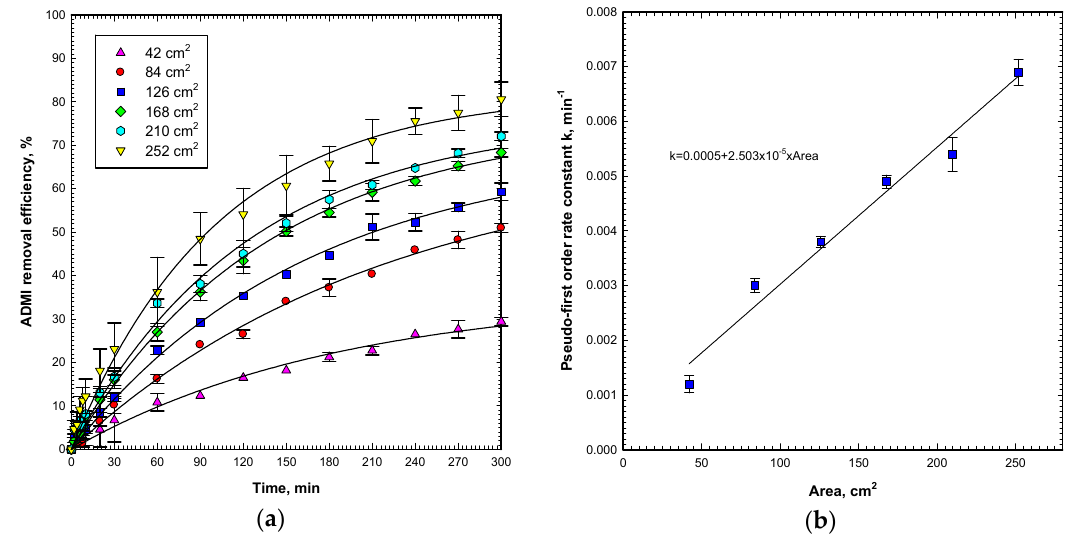
Figure 7. Effect of the loaded area of the catalyst on ( a ) OG degradation and ( b ) the first-order rate constant by the Vis/ZnO process. The operating conditions were: initial OG concentration of 50 mg L − 1 , ZnO dosage of 60 g m − 2 , visible light intensity of 9600 Lux, and reaction time duration of 300 min.